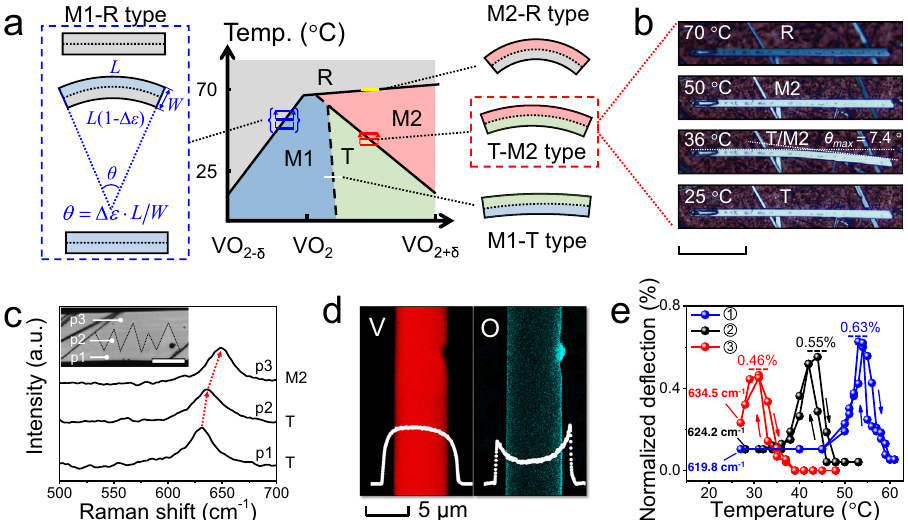
Fig. 3 Single-crystalline VO 2 actuators (SCVA) driven by asymmetric stoichiometry. a Working mechanism of SCVAs with asynchronized phase transition routes. The colored bar, namely the gradient bar, in the phase diagram shows the oxygen gradient along the lateral direction of VO 2 beams at a certain temperature. The group of gradient bars at varying temperatures across the phase boundaries represents the effective actuation process of SCVAs. b Optical images of T-M2 type SCVA at increasing temperature (scale bar is 100 μ m). White dash lines give the maximum de fl ection angle ( θ max ) of the actuator at 36 °C. c Raman spectra of a bending SCVA. The red dash arrows trace the shift of ω O phonon frequency. The inset image shows the measured points (p1 – p3) of the sample (scale bar is 10 μ m) with black dash-lines at the positions of domain walls between M2 and T domains, where dark yellow domains have the typical M2 structure and shallow yellow domains are T phase. d EDS mapping of V and O along a SCVA that bends towards the left side. The white pro fi les show the element distribution across the lateral direction of beam. e Plots of the normalized de fl ection of three T-M2 SCVAs with different oxygen contents (i.e., room temperature ω O